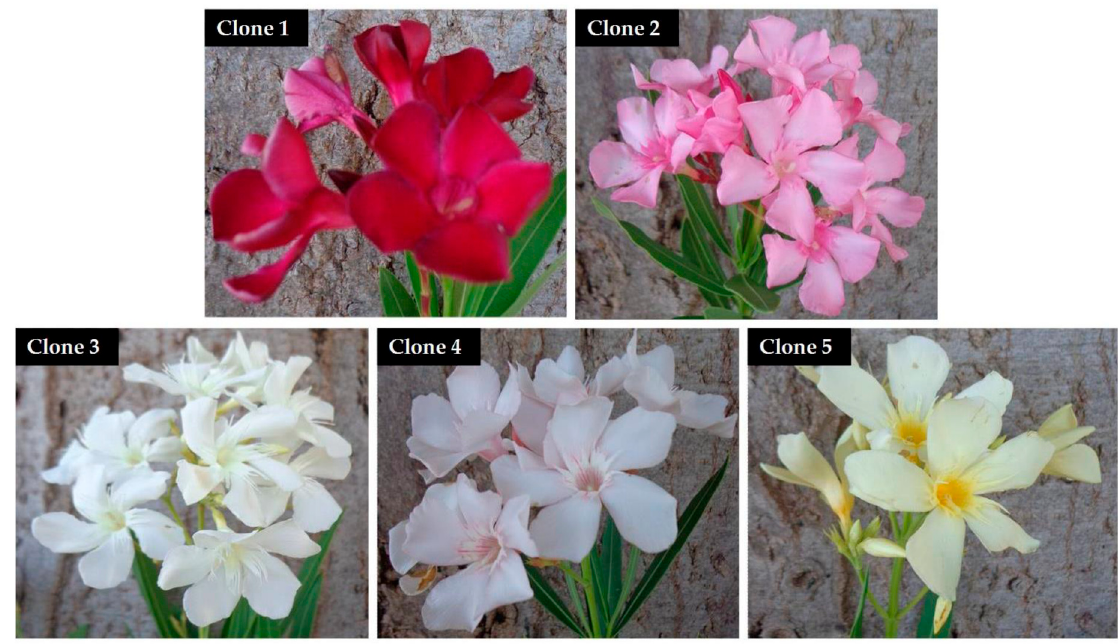
Figure 1. Nerium oleander clones tested.